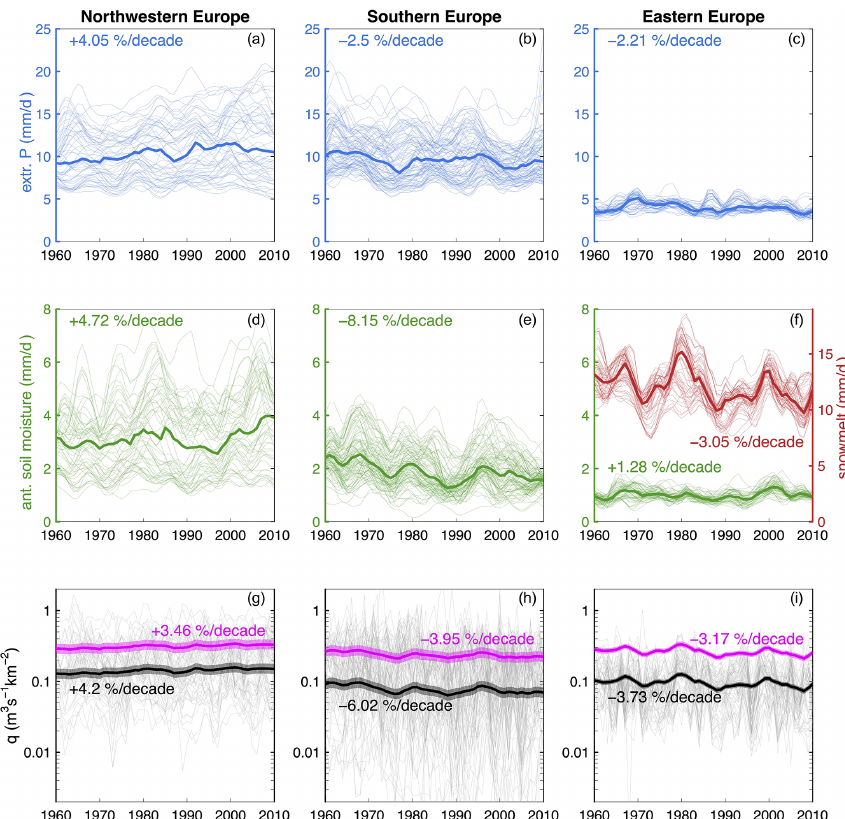
Figure 9. Driver and flood time series in three regions, respectively located in northwestern, southern and eastern Europe. Thin lines represent flood and covariate time series for each station in the three regions. Thick lines in panels (a) to (f) represent the median. Thick lines in panels (g) to (i) represent the posterior median of the flood quantiles, and the shaded regions are the respective 90% credible bounds. Numbers in panels (a) to (f) refer to the average changes in the drivers. Numbers in panels (g) to (i) refer to the sum of the contributions of the three drivers to changes in q 2 (black) and q 100 (magenta), i.e. to the average changes in q 2 and q 100 resulting from this model for S = 1000km 2